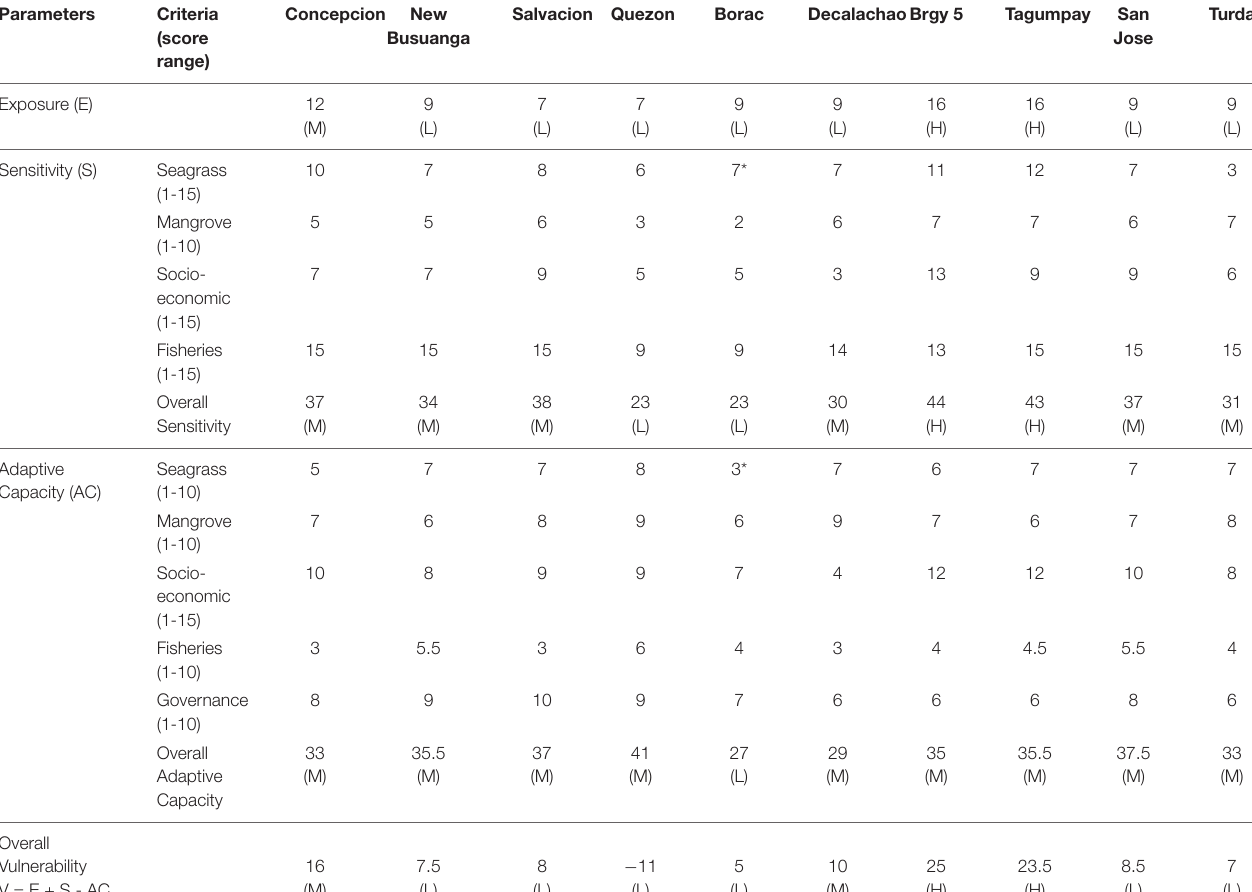
TABLE 5 | Raw vulnerability scores, summed for each criteria, ranked using Table 4 with low (L), medium (M) and high (H) scores.